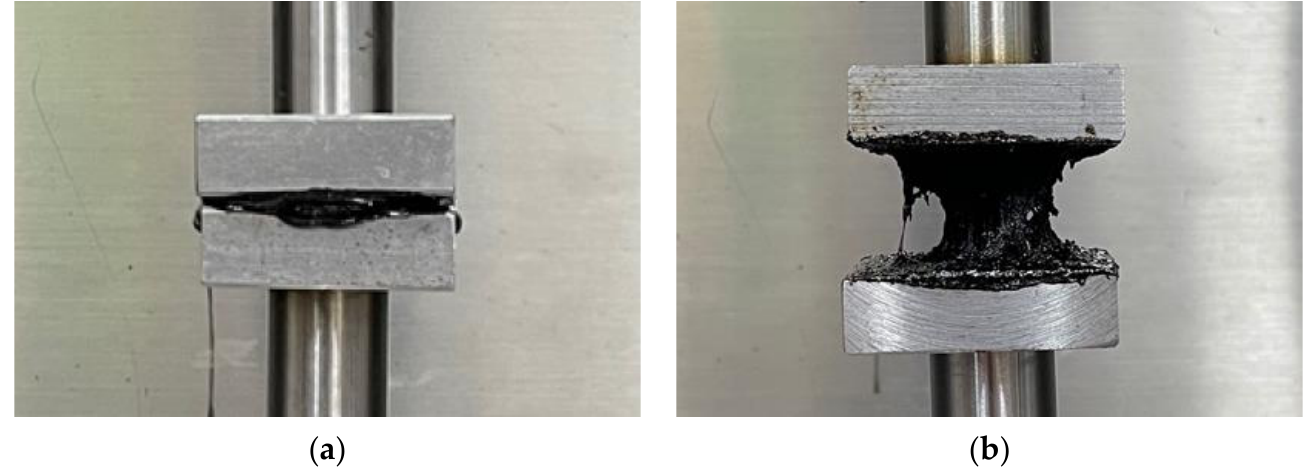
Figure 6. Cohesive strength testing for 2 mm specimen; ( a ) specimen test preparation, ( b ) cohesive strength testing.